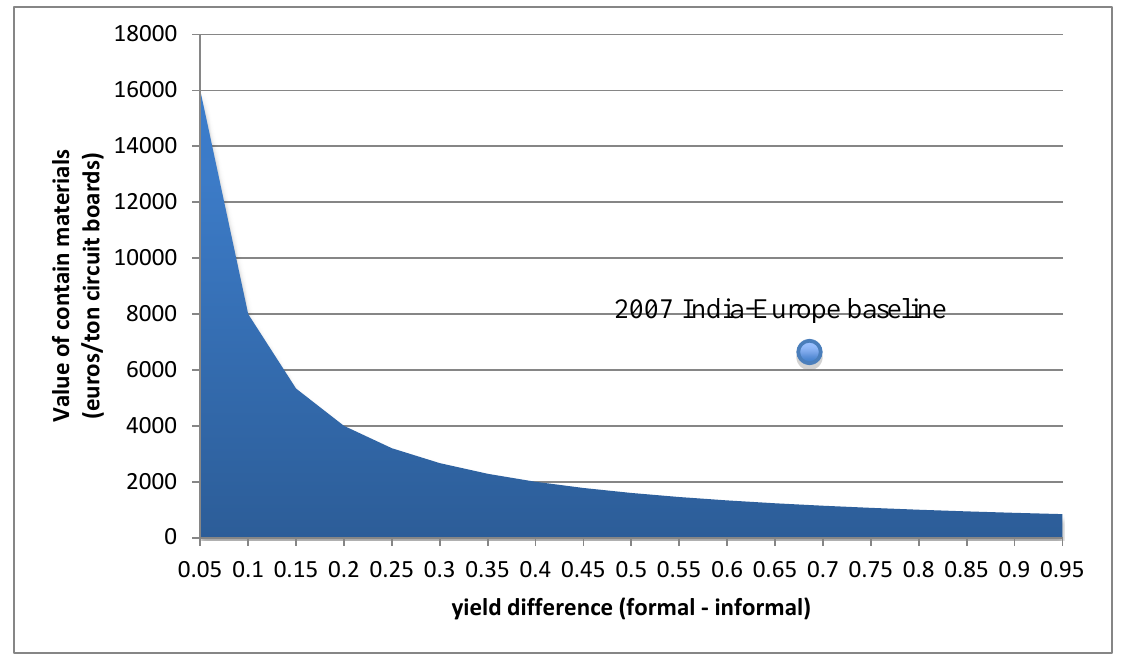
Figure 3. Profitability of transferring circuit boards from informal recyclers in India to formal recyclers in Europe as function of price and technology difference. The shaded area represents the unprofitable